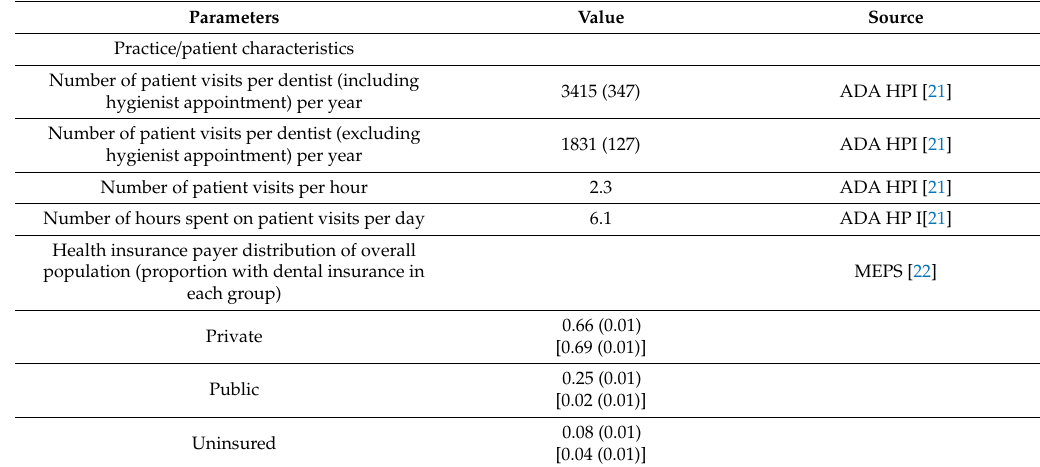
Table 1. Input data for the dental care integration model. Data are expressed as mean